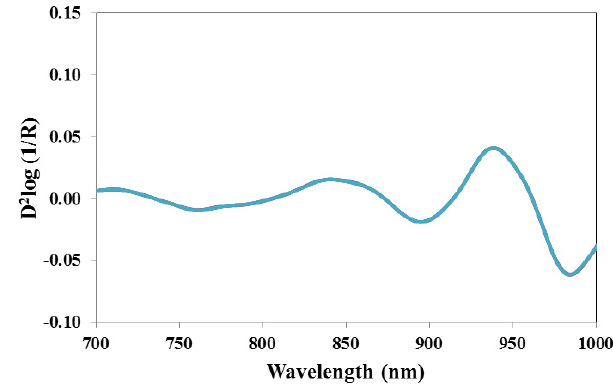
Fig. 4. Scatter plots of predicted and actual values of sugar content in the calibration set.